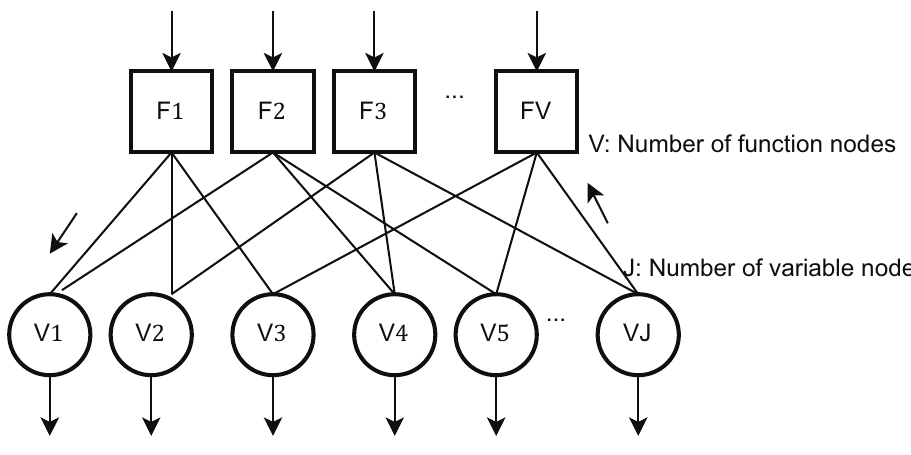
Figure 3. Depiction of the Tanner